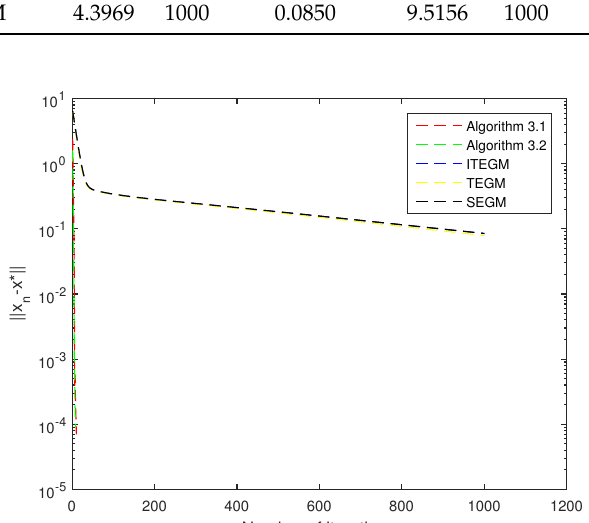
Figure 3. Comparison of all algorithms with m = 50.